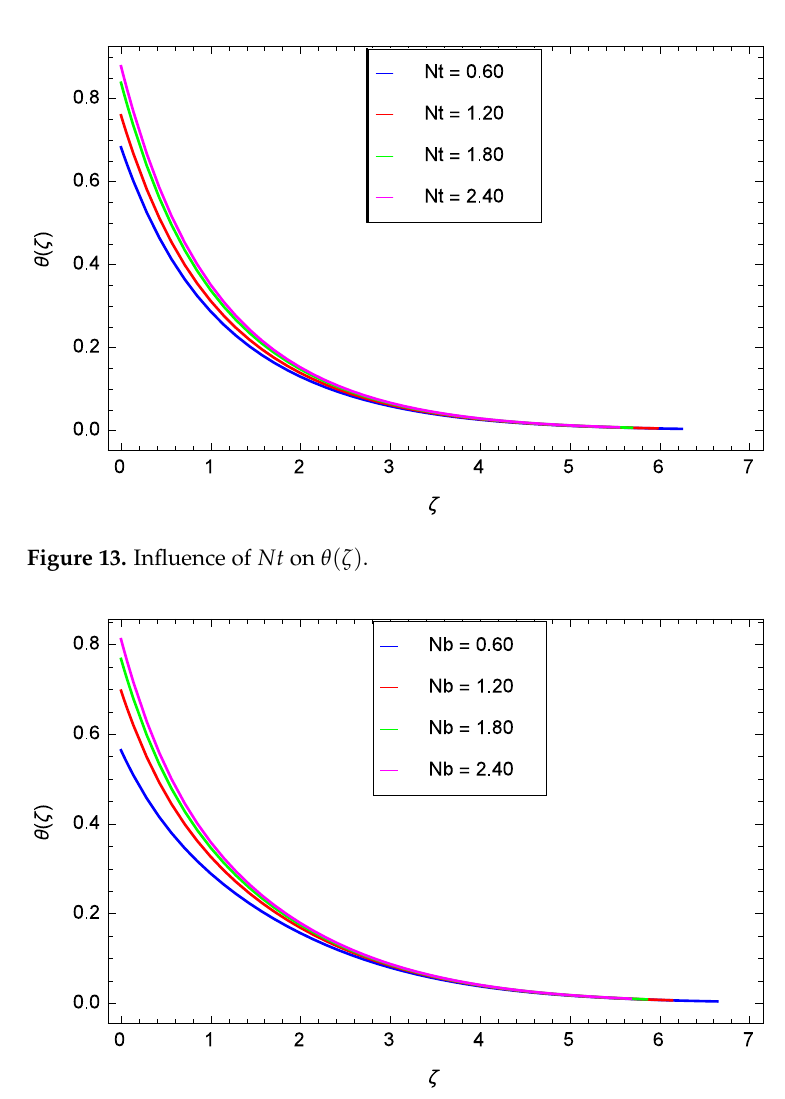
Figure 14. Influence of Nb on θ ( ζ )